Question: Write a single sentence explaining what this figure depicts.
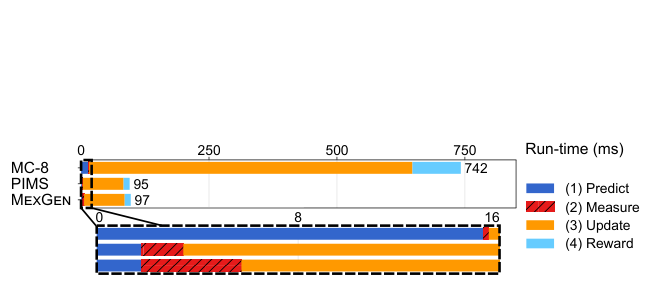
Answer: Run-time analysis results for planners with the different measurement prediction methods running on the processor used on our aerial robot (total time is divided into the planning stages in § IV). Our MEXGEN method achieves 7.6× speed-up compared to MC-8 and significantly better task performance than PIM (see Table I and II). Notably, the relatively small measure time of MC-8 is because PIM and MEXGEN measure times include the cost of the expectation. The results demonstrate the asymmetric computational cost of the measurement function (Measure time) and the belief state update (Update time) we leverage in our approximation.